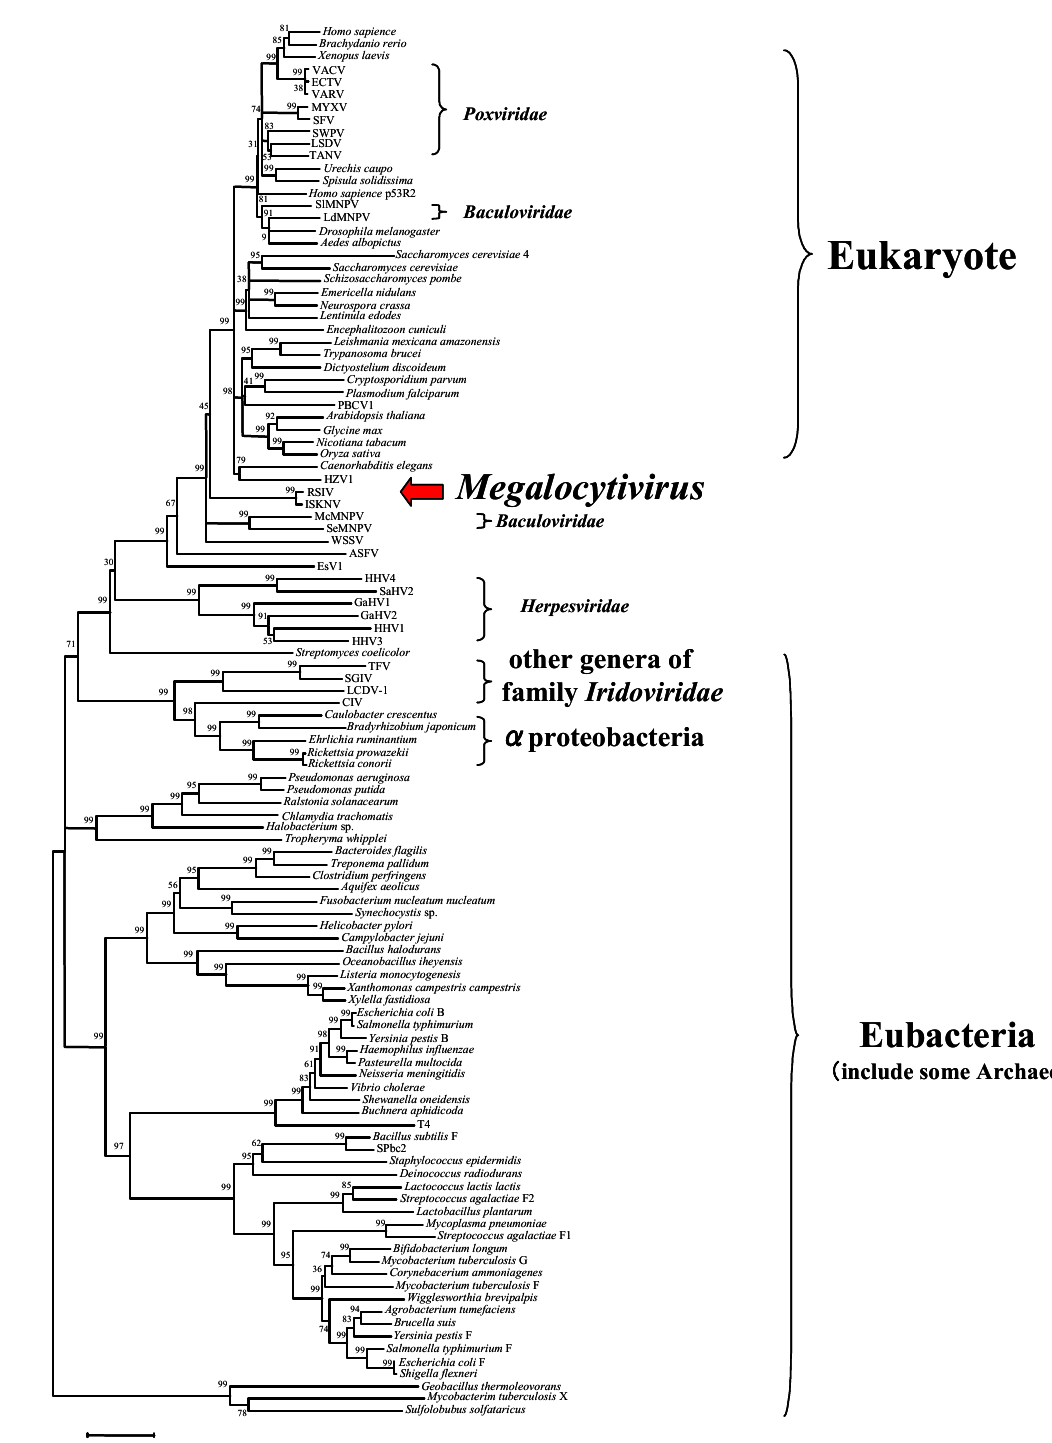
Figure 5 . Phylogenetic analysis of the small subunit of ribonucleotide reductase (RR-2). The tree was constructed by the neighbor-joining method [43] using MEGA (version 4) [44]. Poisson correction was selected as the distance parameter and pair-wise deletion was chosen to handle gaps. The numbers indicate the percentage bootstrap support for each node from 1,000